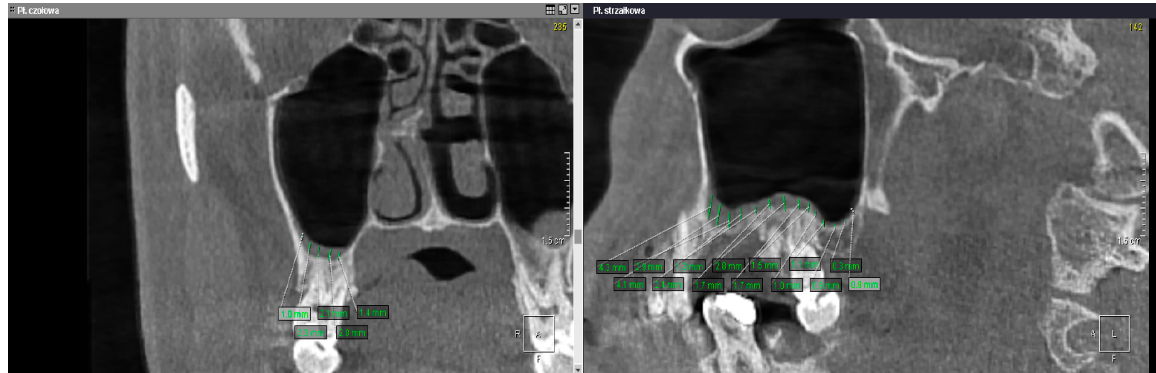
Figure 10. Sample measurement of mucosal